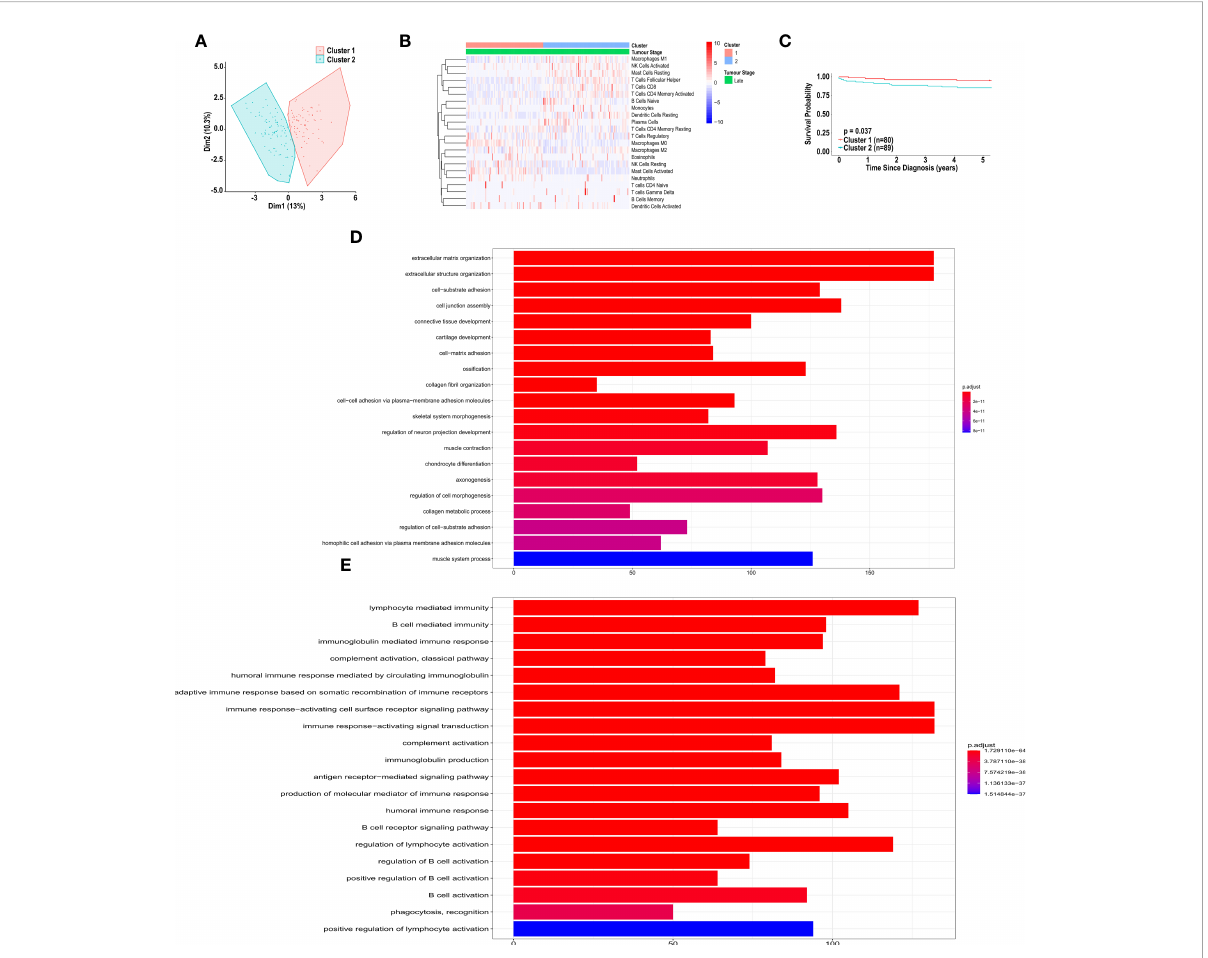
FIGURE 6 Unsupervised clustering of patients with CRC, based on immune cell in fi ltration, using CIBERSORT analysis. (A) Unsupervised clustering of early- stage CRC patients, based on immune cell in fi ltration, using CIBERSORT analysis. (B) Heatmap of immune cell in fi ltration, of patients in cluster 1 and 2, based on CIBERSORT analysis. (C) Kaplan-Meier curve for overall fi ve-year survival for clusters 1 and 2, resulting from unsupervised clustering for early-stage CRC patients, based on CIBERSORT analysis. (D) Pathway analysis of genes down-regulated in cluster 2 vs. cluster 1, based on unsupervised clustering of patients with early-stage CRC. (E) Pathway analysis of genes up-regulated in cluster 2 vs. cluster 1, based on unsupervised clustering of patients with early-stage CRC. Groups with high and low cell numbers were compared with log-rank